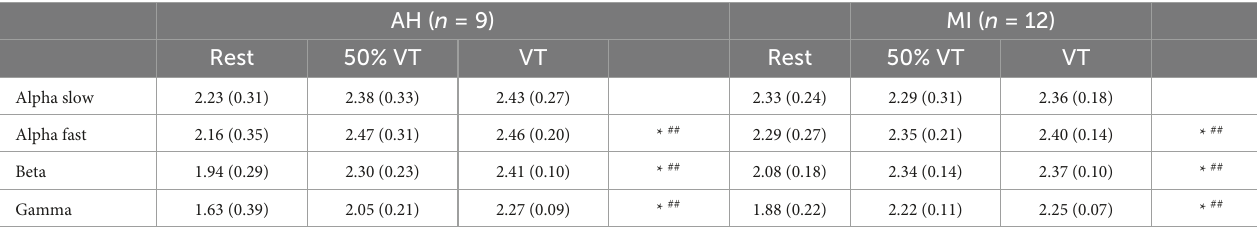
TABLE 4 Electroencephalography (EEG) responses (mean ± SD) in AH and MI in the motor cortex at rest, 50% VT and VT. AH ( n = 9) MI ( n = 12)